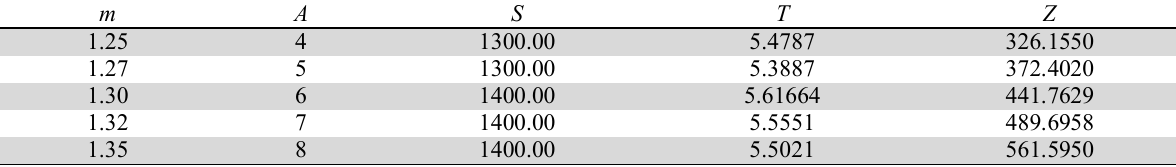
Optimal solution for different values of mark-up rate